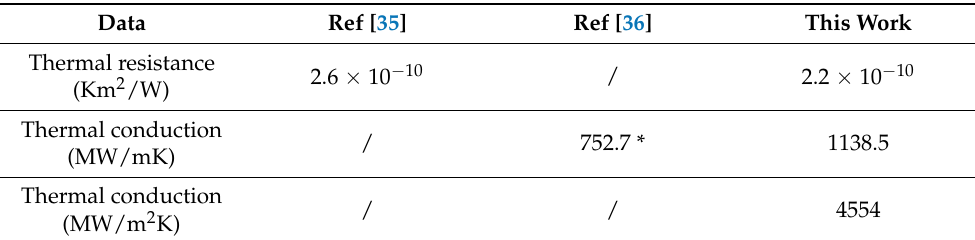
Table 1. Comparison of our results with others in the forward